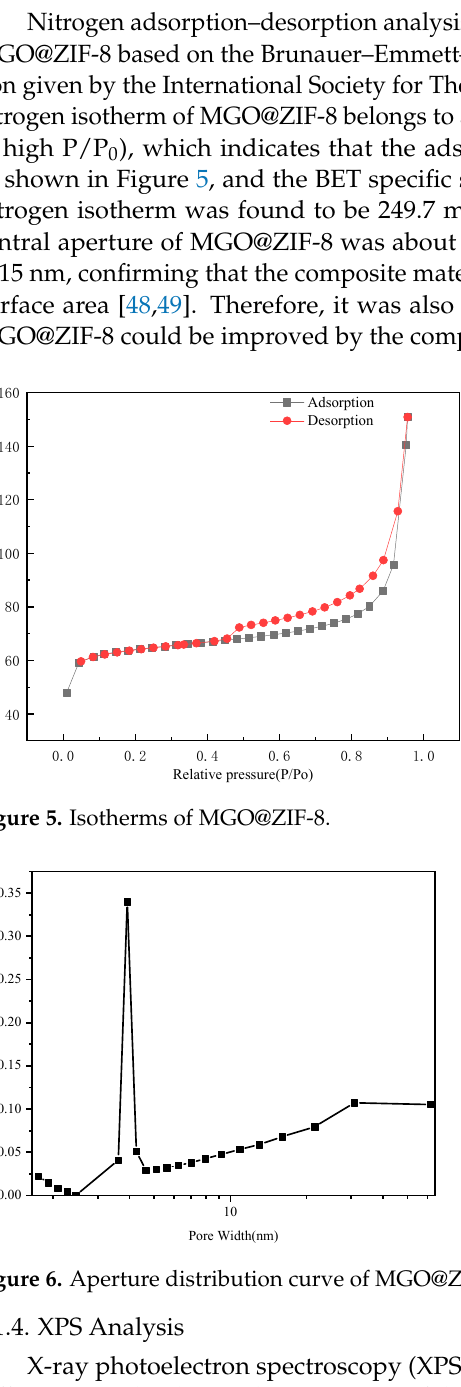
Figure 4. ( a ) XRD patterns of the samples; ( b ) FT-IR spectra analysis.